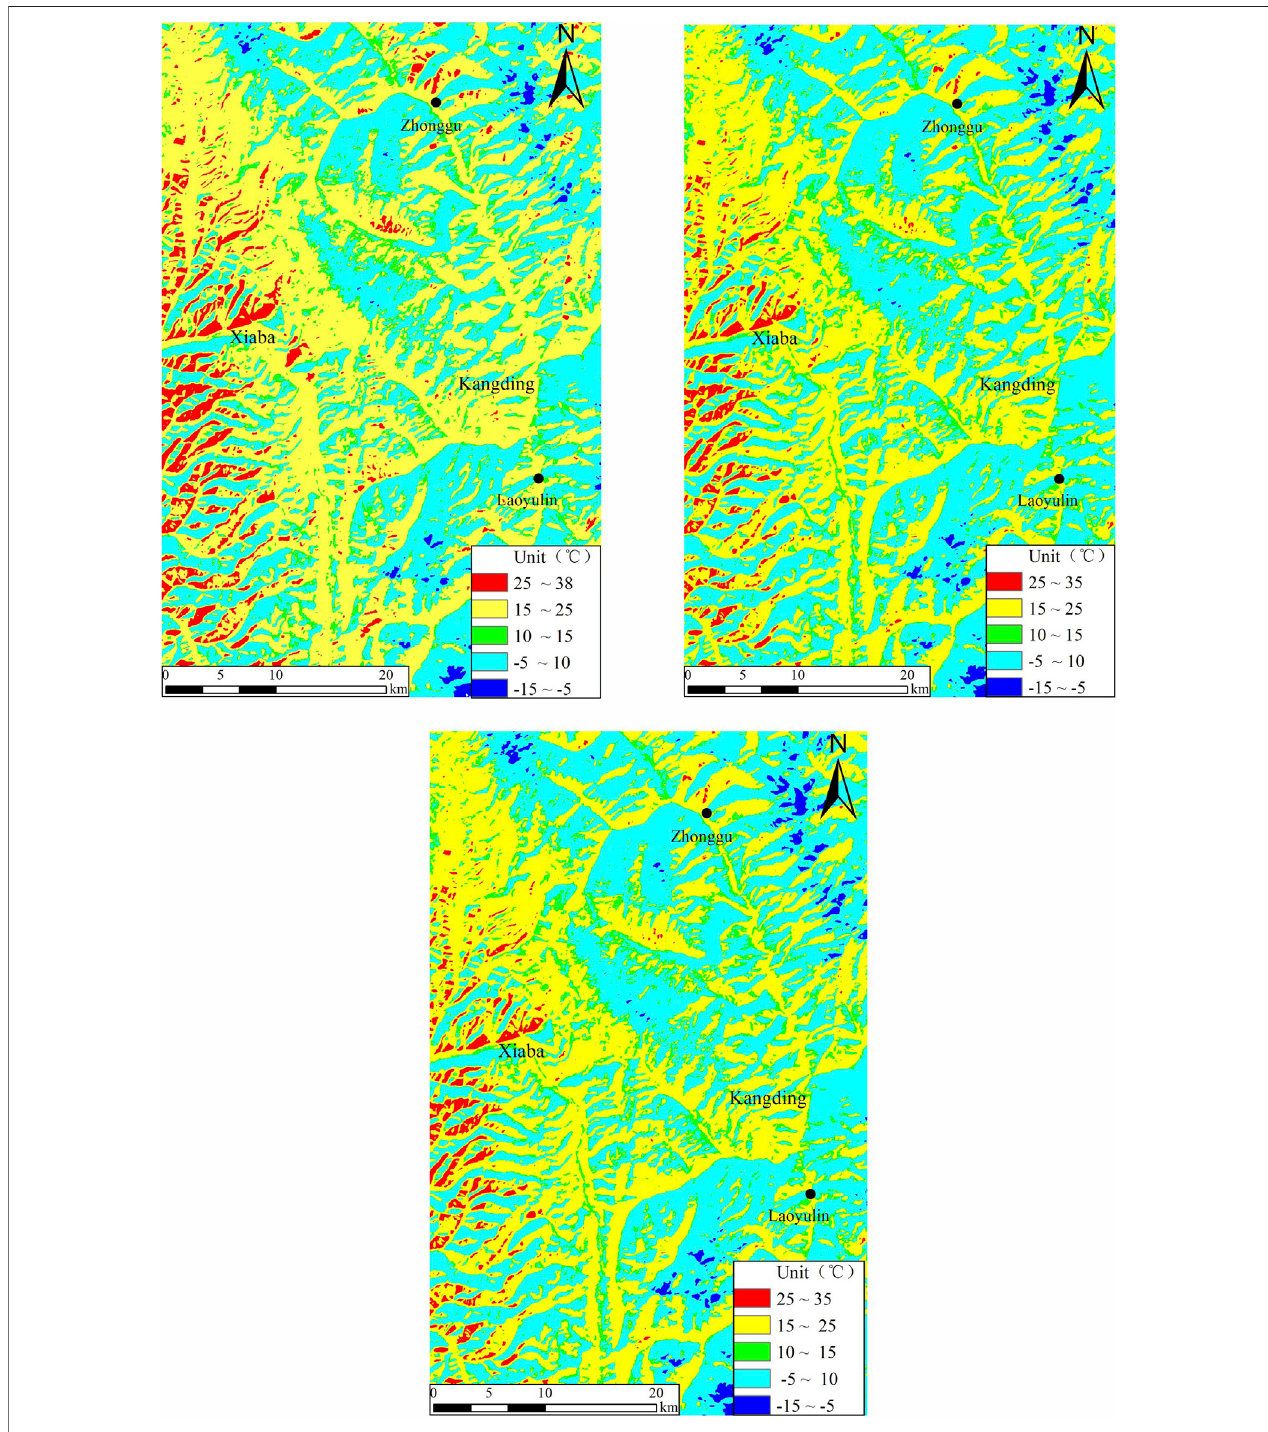
FIGURE 2 | Plot of LST retrieval results of three algorithms. From left to right: (A) RTE; (B) MW; and (C) SW.